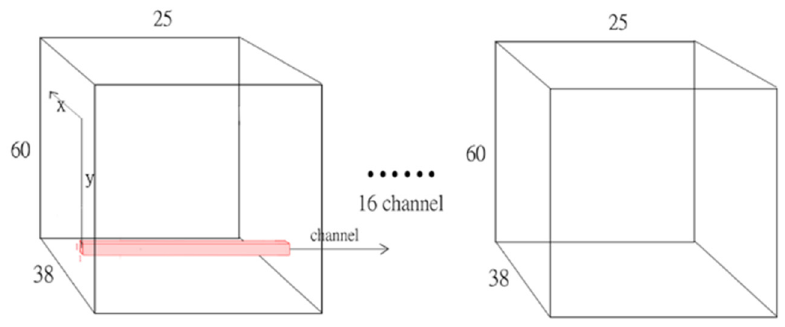
Figure 9. Learnable depth compaction.